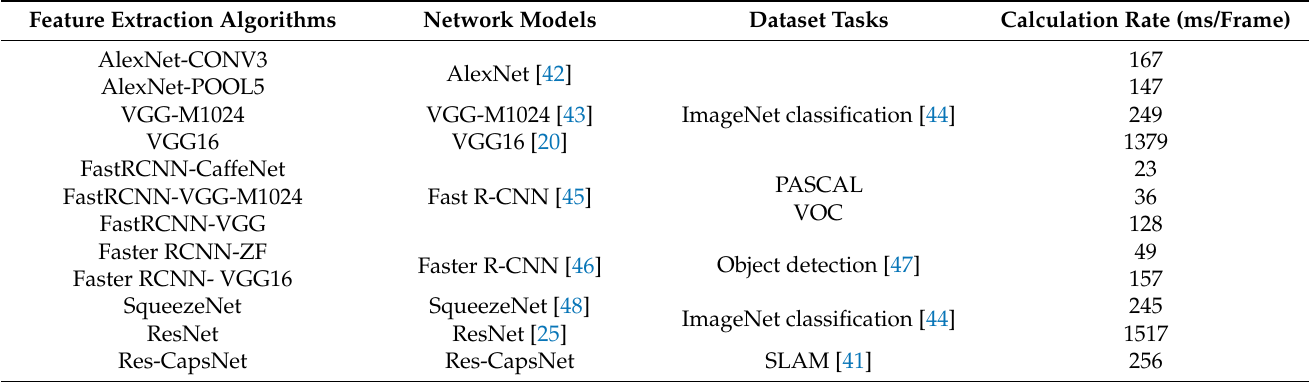
Table 4. Time consumption of feature extraction